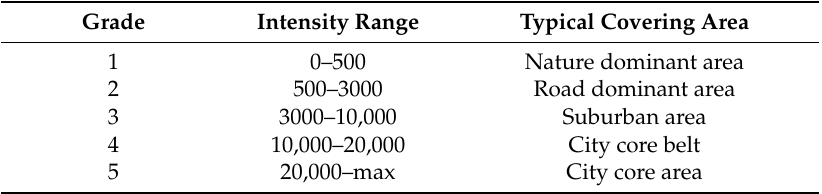
Table 2. Grading standard of human activity